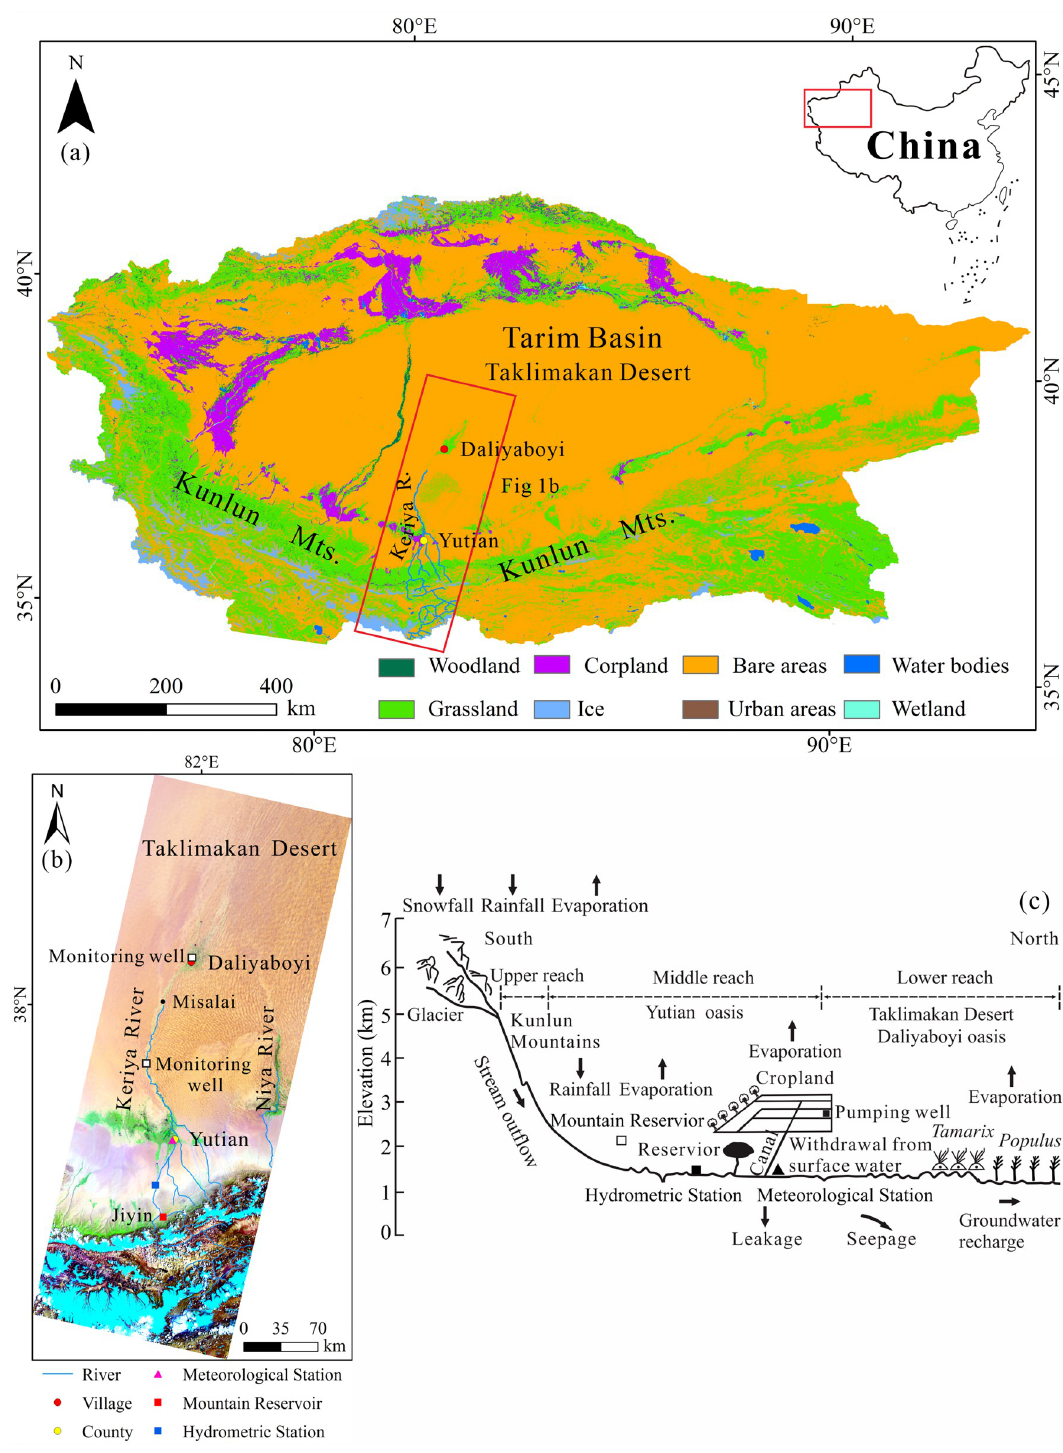
Fig 1. (a) Location of the Tarim Basin in China, and land cover in 2018 in the Tarim Basin. Land-cover map is available for download through the Copernicus Climate Change Service (C3S) Climate Data Store (CDS), at a spatial resolution of 300-m. The China map was downloaded from http://bzdt.ch.mnr.gov.cn/, and the grant number is GS(2020)3183; (b) The Landsat 8 OLI images based on a composite of Band 7 (Red), 5 (Green) and 2 (Blue). Images show the location of the Keriya River Basin. The river channel north of Misalai is ephemeral; south of Misalai the channel is perennial. (c) Conceptual model describing the controls on the variations in